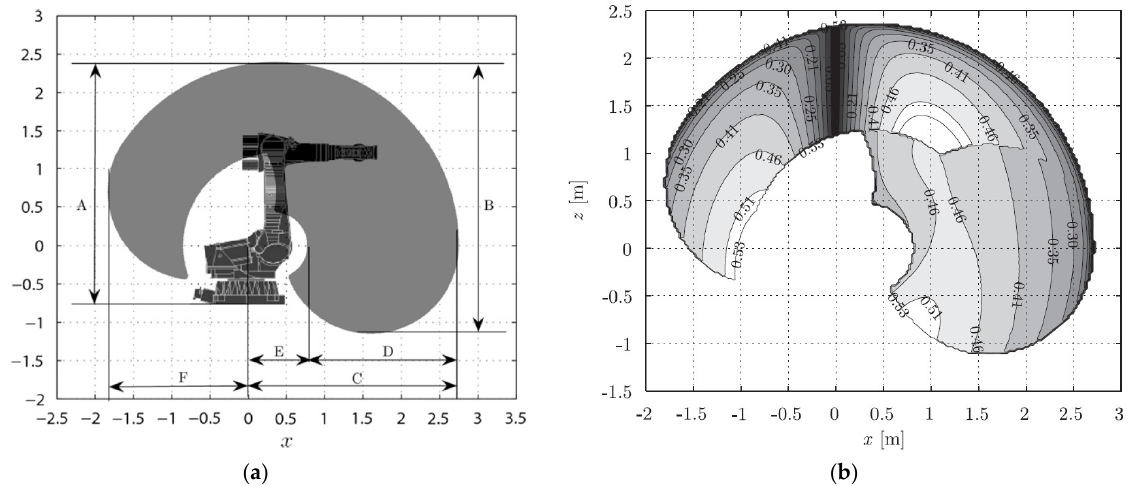
Figure 9. Distribution of the inverse condition number in the Cartesian workspace of a KUKA robot [109]: ( a ) Cartesian workspace of the KUKA KR240−2 robot and ( b ) contours of the inverse condition number of J N